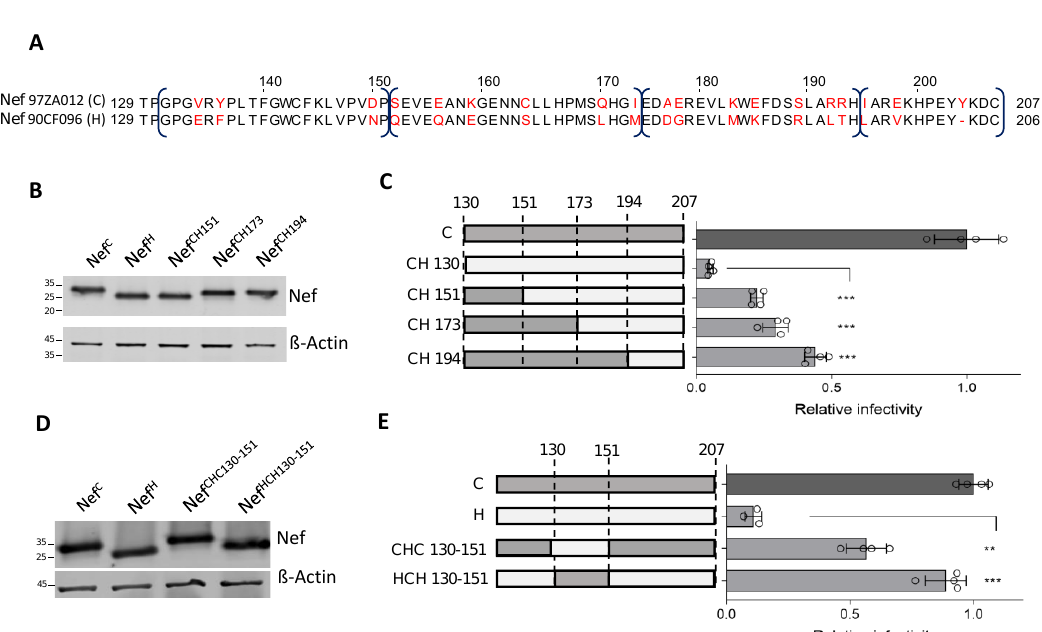
Figure 3. A 21 amino acid sequence from Nef C rescues the SERINC5 counteracting activity of Nef H . 335